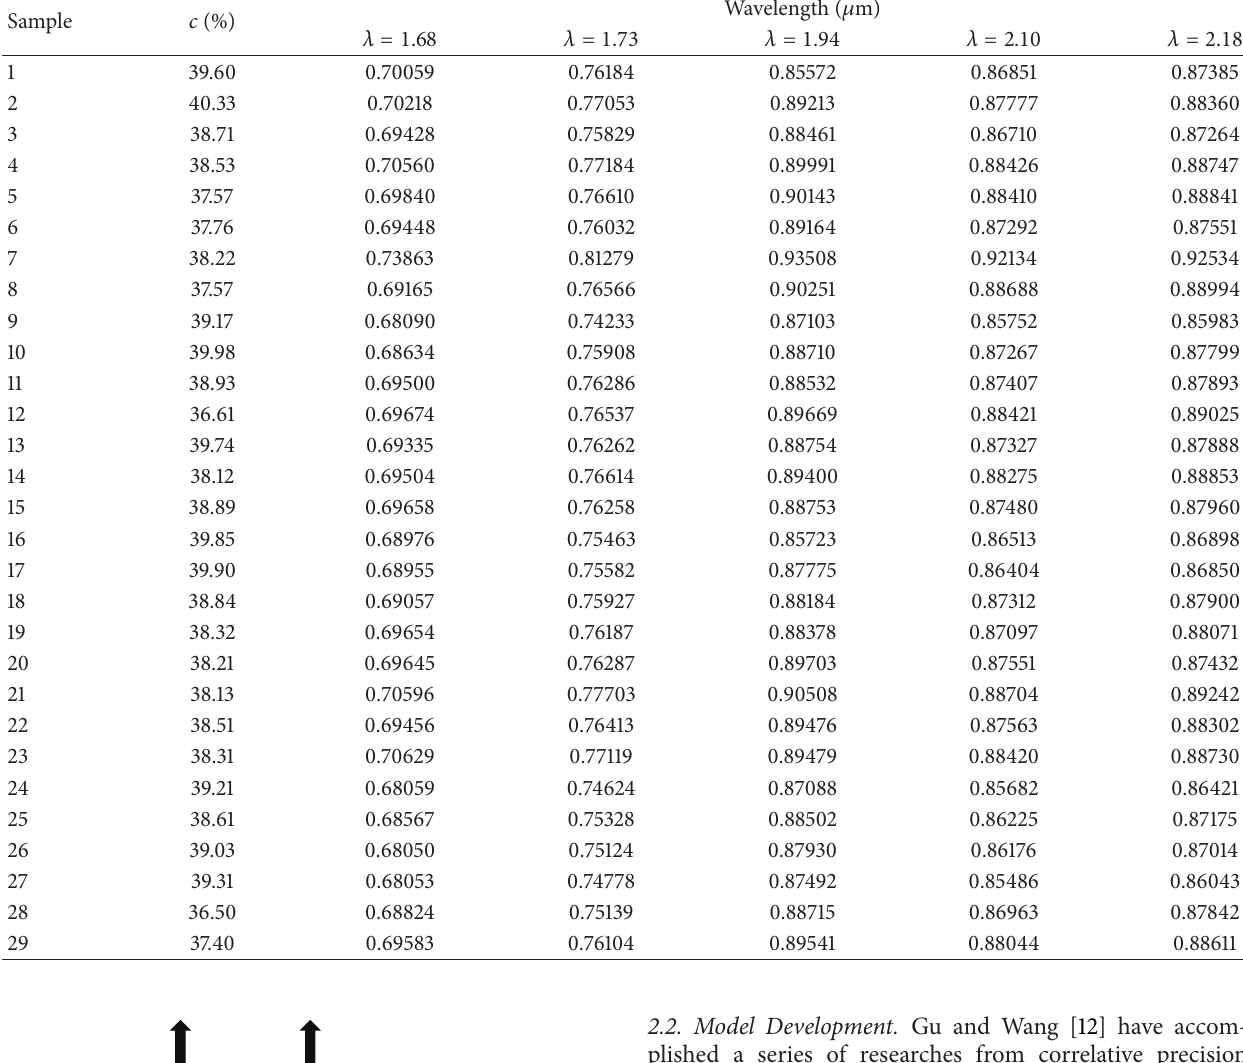
Table 1: Data of 29 rapeseed samples.